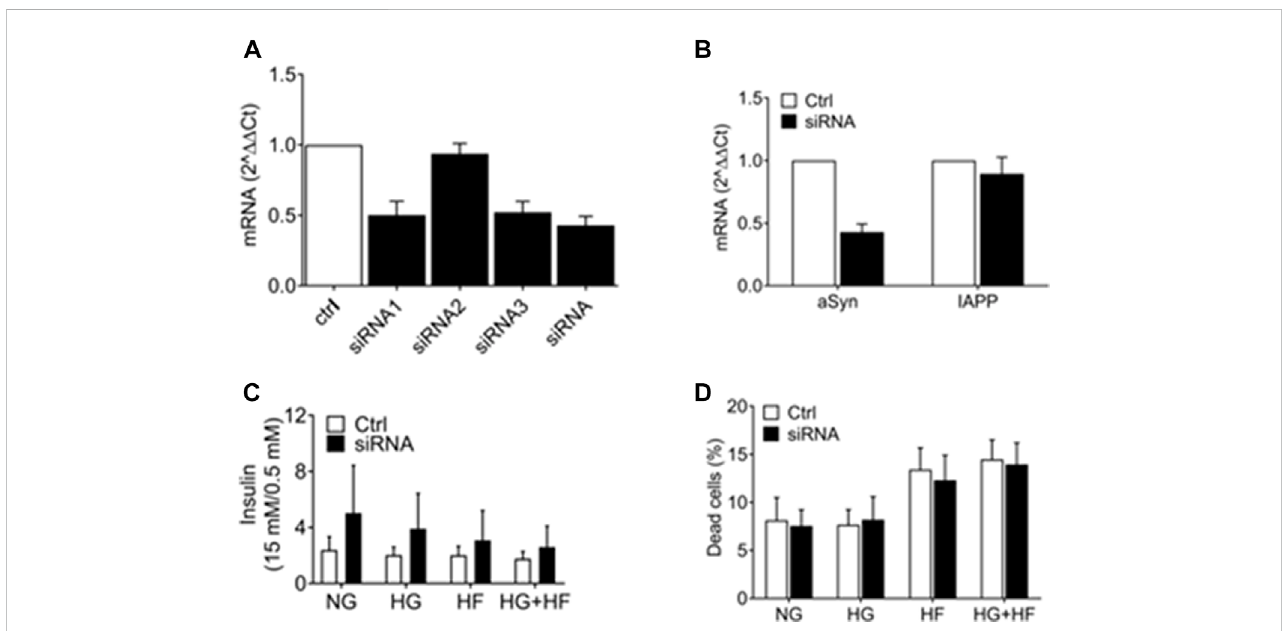
FIGURE 5 aSyn knockdown did not affect insulin secretion in EndoC- β H1 cells. The ef fi ciency of 3 different aSyn siRNAs was tested in EndoC- β H1 cells, and mRNA levels were analyzed at 48 h post-transfection. (A) SiRNA1, siRNA3, and pooled siRNA (siRNA) reduced aSyn mRNA level by 50%. SiRNA2 did not reduce aSyn mRNA level. (B) SiRNA reduced aSyn mRNA level while did not alter IAPP mRNA level. Data were normalized to GUSb and correlated to control siRNA. Transfected EndoC- β H1 were exposed to normal glucose (5.5 mM, NG), high glucose (20 mM, HG), high fat (1.5 mM sodium palmitate, HF) or high glucose plus high fat (20 mM glucose and 1.5 mM sodium palmitate, HG + HF) condition for 48 h before being analyzed. (C) Glucose-stimulated insulin secretion (GSIS) was analyzed using alphaLISA, where no signi fi cant difference in GSIS fold change was observed between the control and